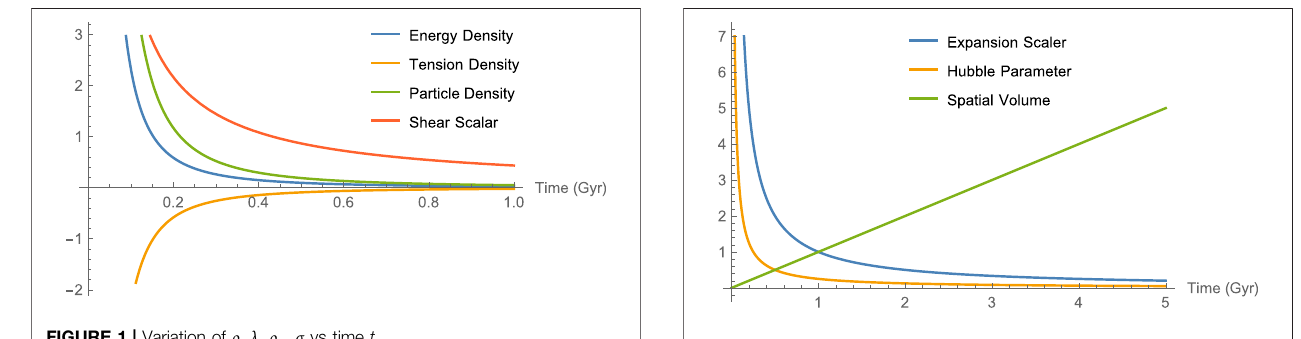
FIGURE 1 | Variation of ρ , λ , ρ p , σ vs time t .